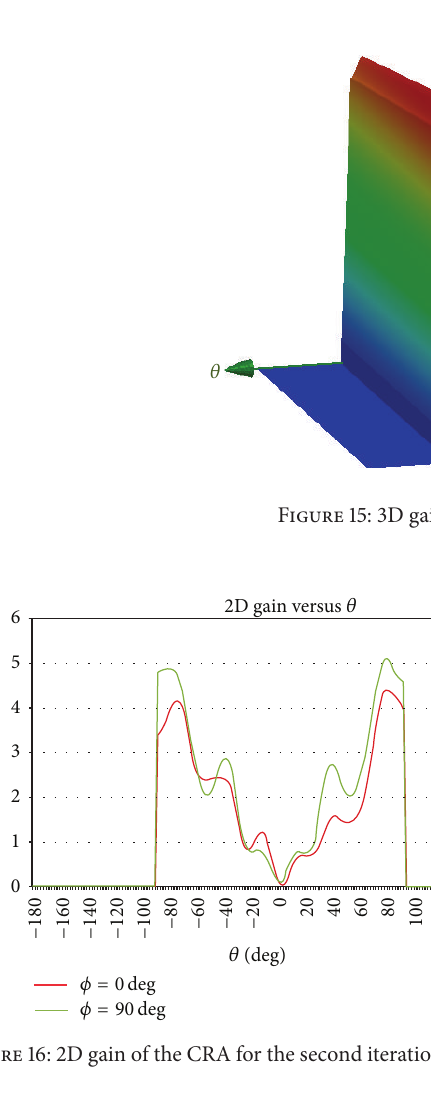
Table 2: The three cases.